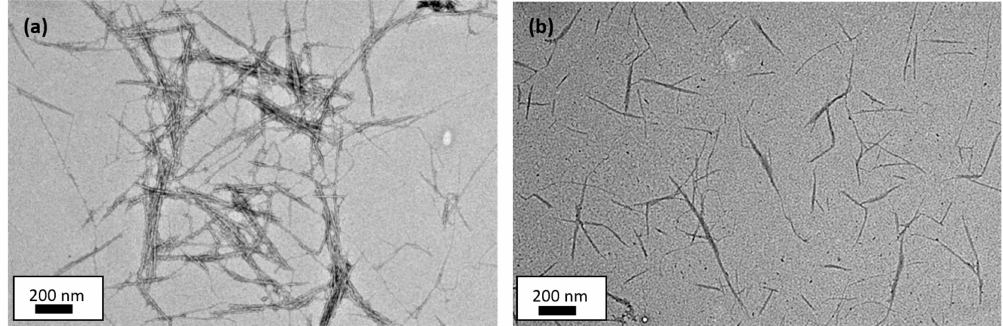
Figure 2. The TEM images of ( a ) unbleached NCC (NCC-UB) and ( b ) bleached kenaf core NCC (NCC-B).